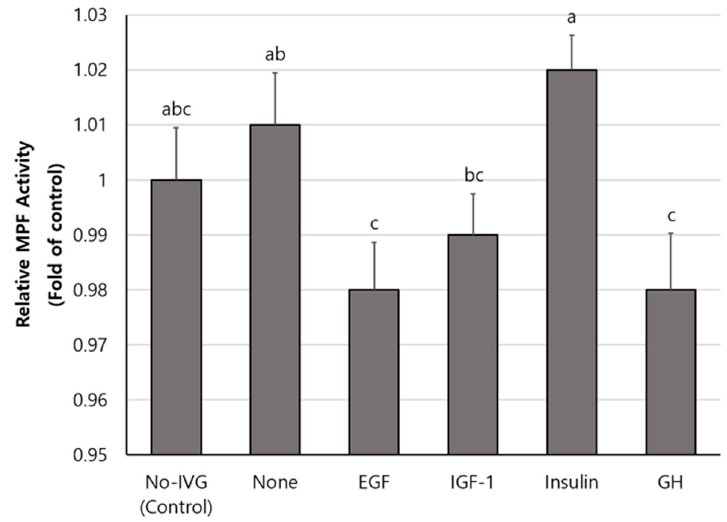
Figure 2. Maturation-promoting factor (MPF) activity (mean ± SEM) after in vitro maturation of small antral follicle-derived oocytes that were treated with various growth factors or hormones during in vitro growth (IVG). MPF activity was analyzed in four replicates by sampling 50 mature oocytes for each treatment. Different letters (a–c) in the bar indicate significant differences among treatment groups ( p < 0.05). Table 6. A comparison of oocyte maturation and embryonic development after parthenogenesis (PA) of small antral follicle (SAF)-derived oocytes treated with insulin during in vitro growth (IVG) culture with those of oocytes derived from medium antral follicles